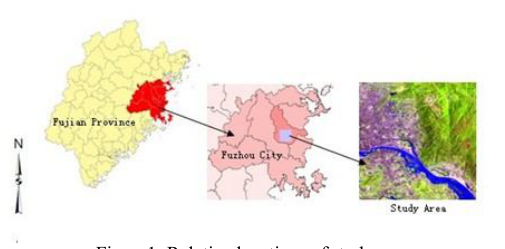
Table1 ． Land use classification scheme of the test area